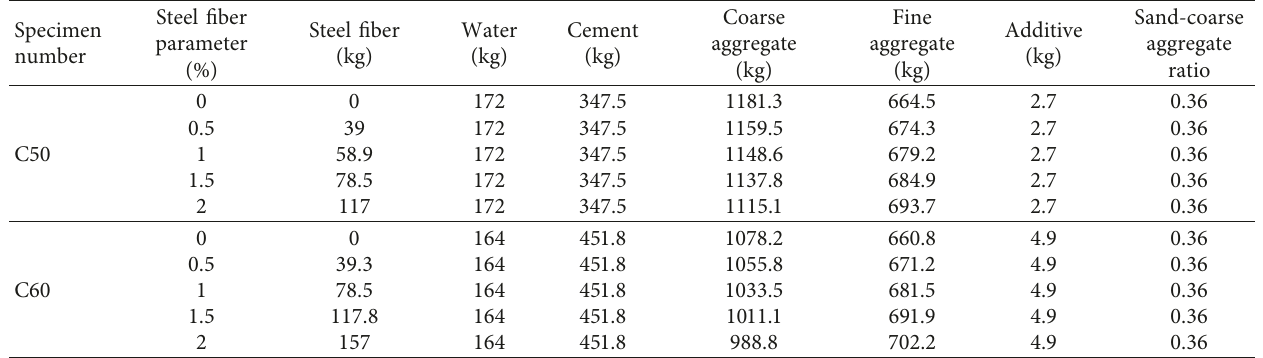
Table 1: Test mix of steel fiber